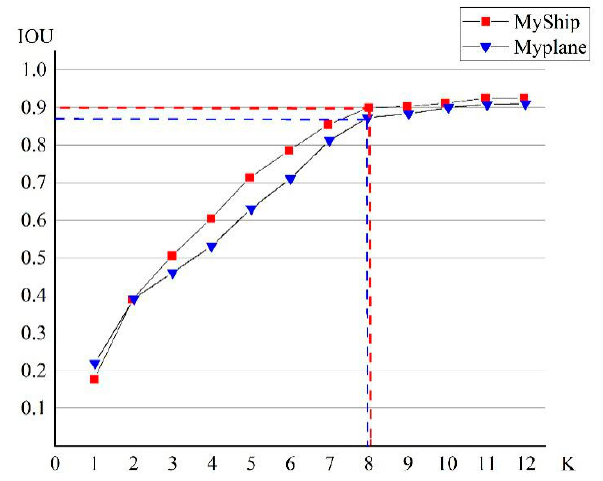
Figure 7. The clustering results of MyPlane and Myship datasets.